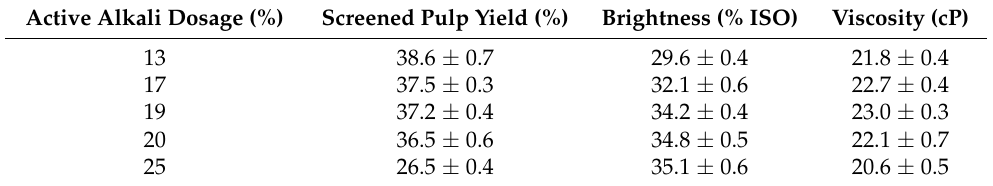
Table 2. The brightness and viscosity of Nypa fruticans frond pulp obtained through prehydrolysis for 3 h at 150 ◦ C followed by soda-SAQ cooking for 1.5 h at 160 ◦ C *. Active Alkali Dosage (%) Screened Pulp Yield (%) Brightness (% ISO) Viscosity